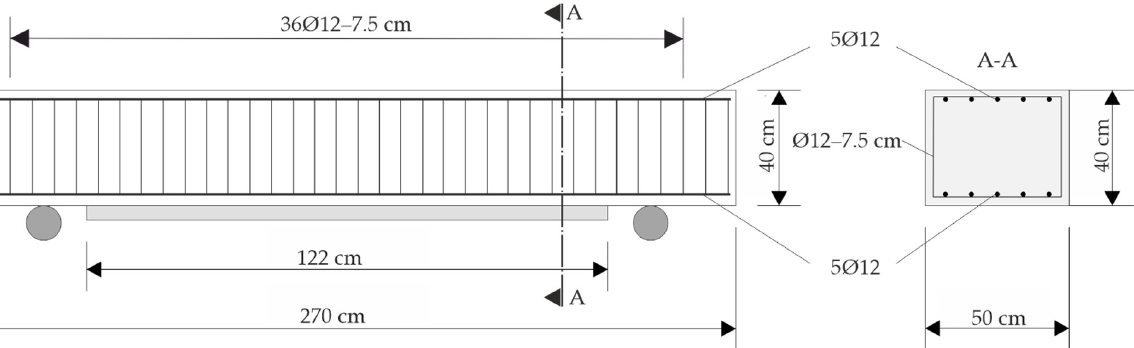
Figure 15. Dimensions of the specimens and their reinforcement. (Graphic: CARBOCON GMBH).